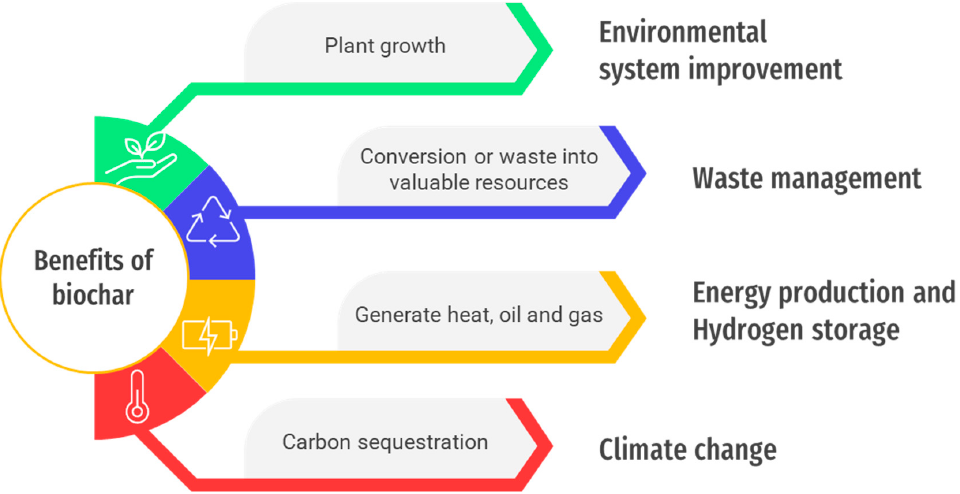
Figure 1. Utilization of biochar in various environmental sectors [16–19].